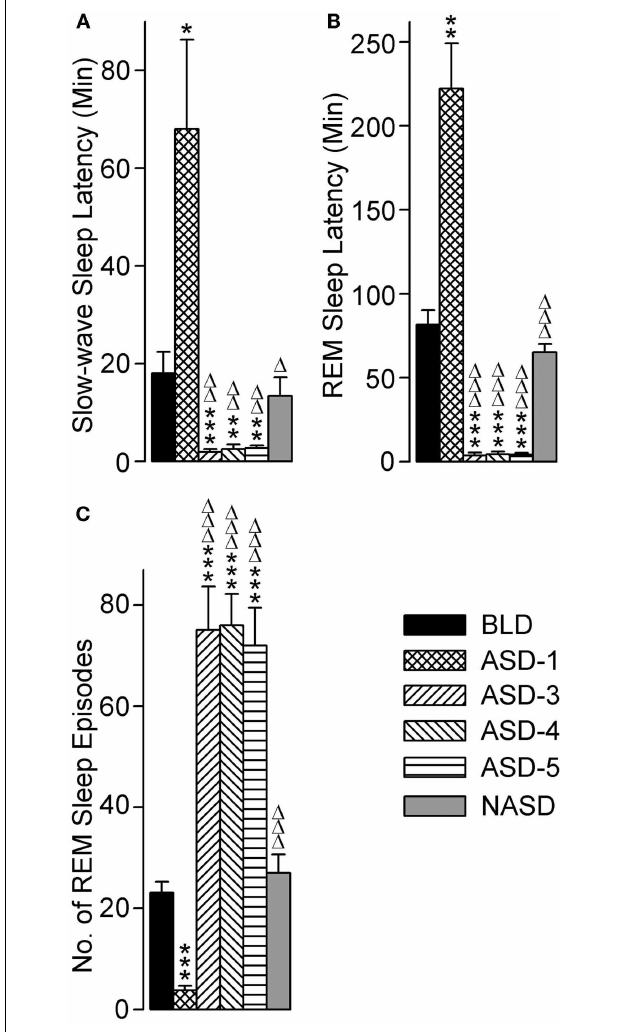
FIGURE 6 | Progressive effects of repetitive anxiogenic stressor (AS) exposure on (A) slow-wave sleep latency, (B) REM sleep latency, and (C) total number of REM sleep episodes. Abbreviations: BLD, no exposure to AS baseline day; ASD-1, day 1 of AS exposure; ASD-3, day 3 of AS exposure; ASD-4, day 4 of AS exposure; ASD-5, day 5 of AS exposure; NASD, no exposure to AS day. *Represents a significant difference from BLD: * p < 0.05, ** p < 0.01, *** p < 0.001. ∆ represents a significant difference from ASD-1: ∆ p < 0.05, ∆∆ p < 0.01, ∆∆∆ p <